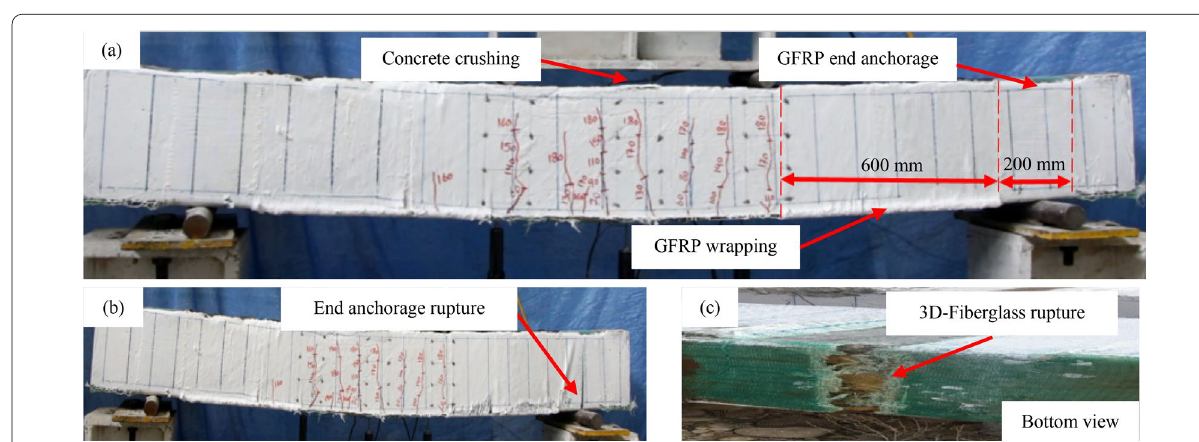
Fig. 13 Failure mechanism and details of failure modes of R3DTR